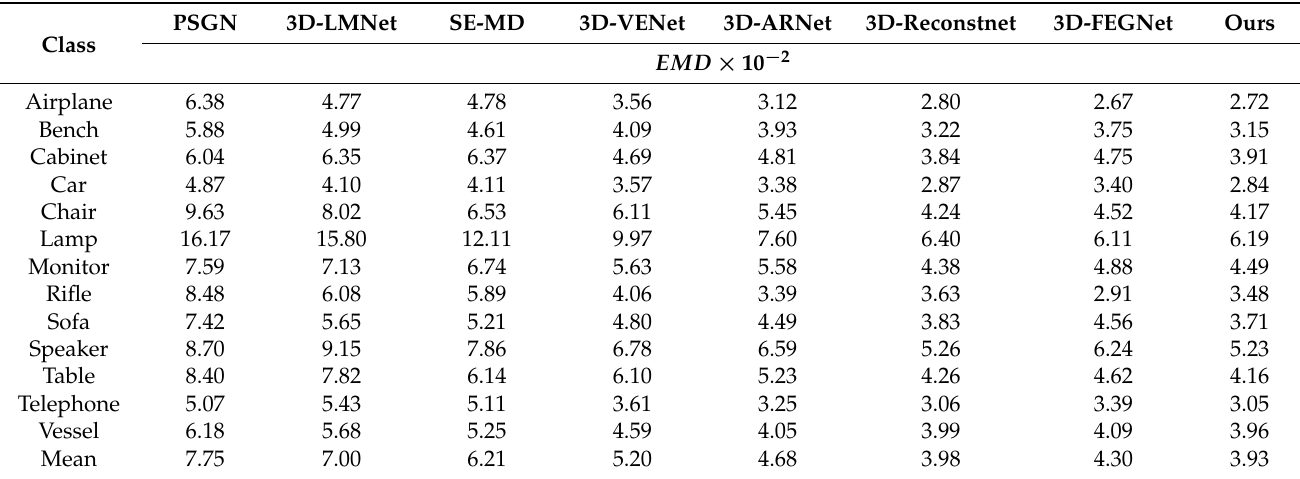
Table 4. Reconstruction results on ShapeNet evaluated by